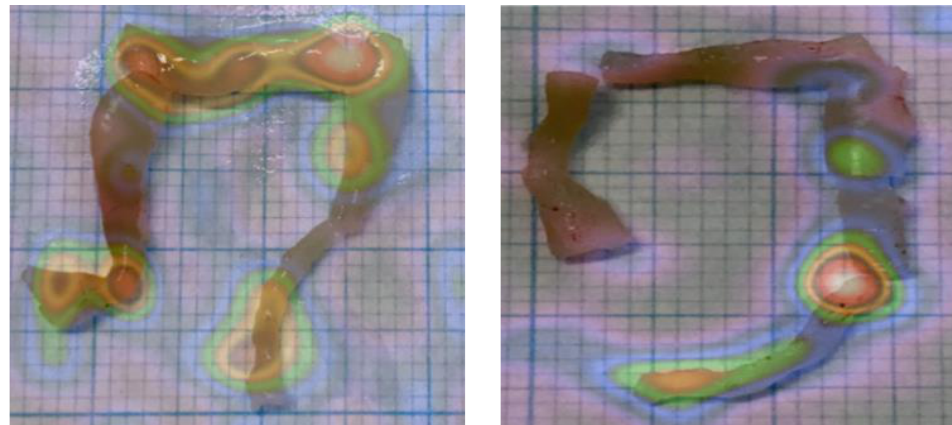
Figure 5. Representative ex vivo images of colons from DSS mice after injection of 99m Tc-anti- α 4 β 7 ( left ) and 99m Tc-anti-TNF α ( right ). Similarly to Figure 4, 99m Tc-anti- α 4 β 7 integrin accumulates particularly in the transvers and descending colon, while 99m Tc-anti-TNF α accumulates particularly in the descending colon and rectum. SPECT/CT scans confirmed accumulation in the large bowel of 99m Tc-anti- α 4 β 7 inte- grin and 99m Tc-anti-TNF α mAb (Figure 6).